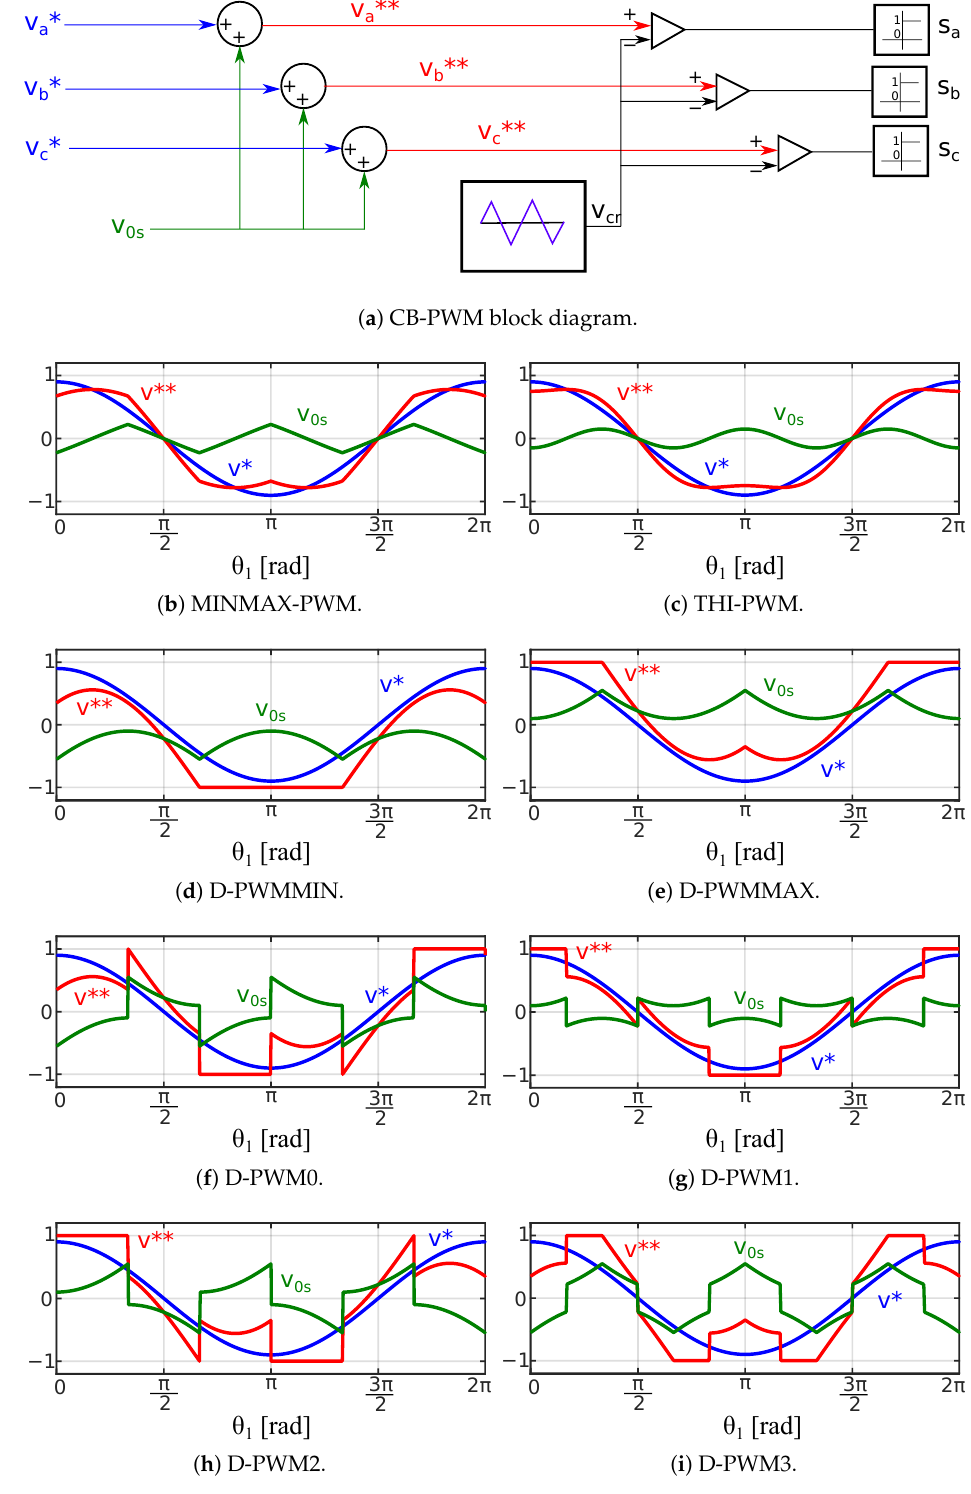
Figure 2. CB-PWM block diagram as well as their voltage references and zero sequence signals. CB-PWM techniques applied in a “split” six-phase inverter are commonly known as double zero-sequence injection (DZSI) PWM techniques because this implies injecting one zero-sequence component ( v 0 s ) into each three-phase structure [25]. They can be classified into continuous and discontinuous modulation techniques [31]. Sinusoidal PWM (SPWM, as the zero sequence signal which is injected in SPWM is 0, sometimes it is not